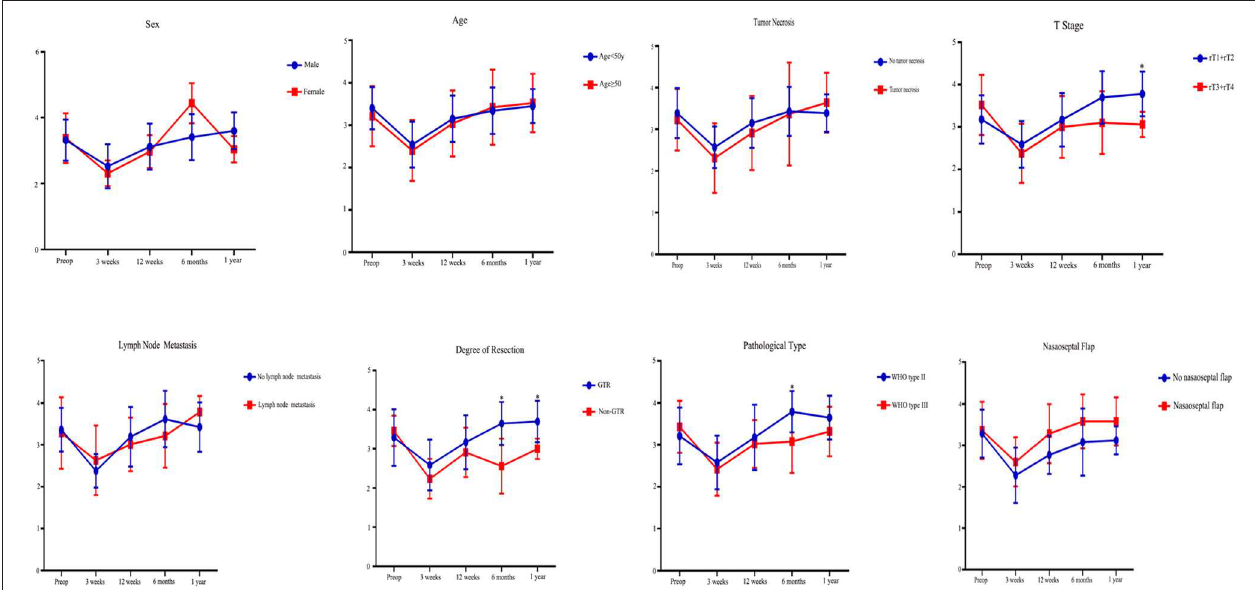
FIGURE 2 | Univariate analysis of Anterior Skull Base Questionnaire (ASBQ) scores for patients who underwent endoscopic nasopharyngectomy for recurrent nasopharyngeal carcinoma. A higher score indicates better quality of life. The y -axes represent the scores. * p < 0.05 (two-tailed t test).